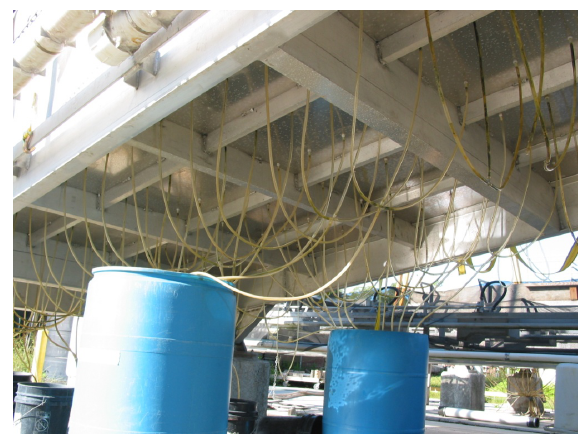
Figure 6. Effluent collection